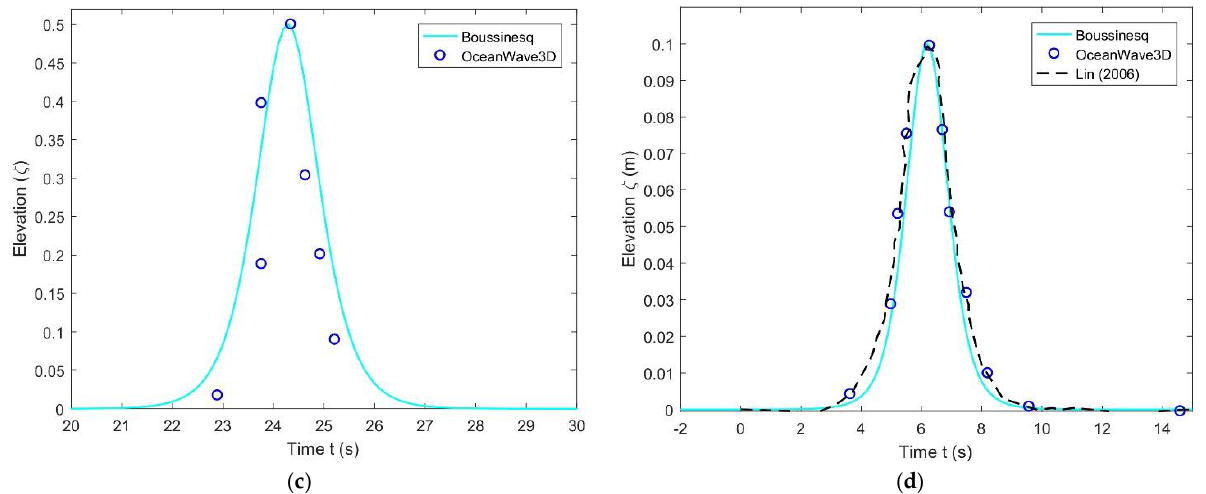
Figure 6. Comparison of the solitary waveform between analytical and OceanWave3D model simulations with ( a ) Comparison for ε = 0.1, ( b ) Comparison for ε = 0.3, ( c ) Comparison for ε = 0.5 versus time t (s) and ( d ) comparison between analytical, CFD and external numerical model [31].